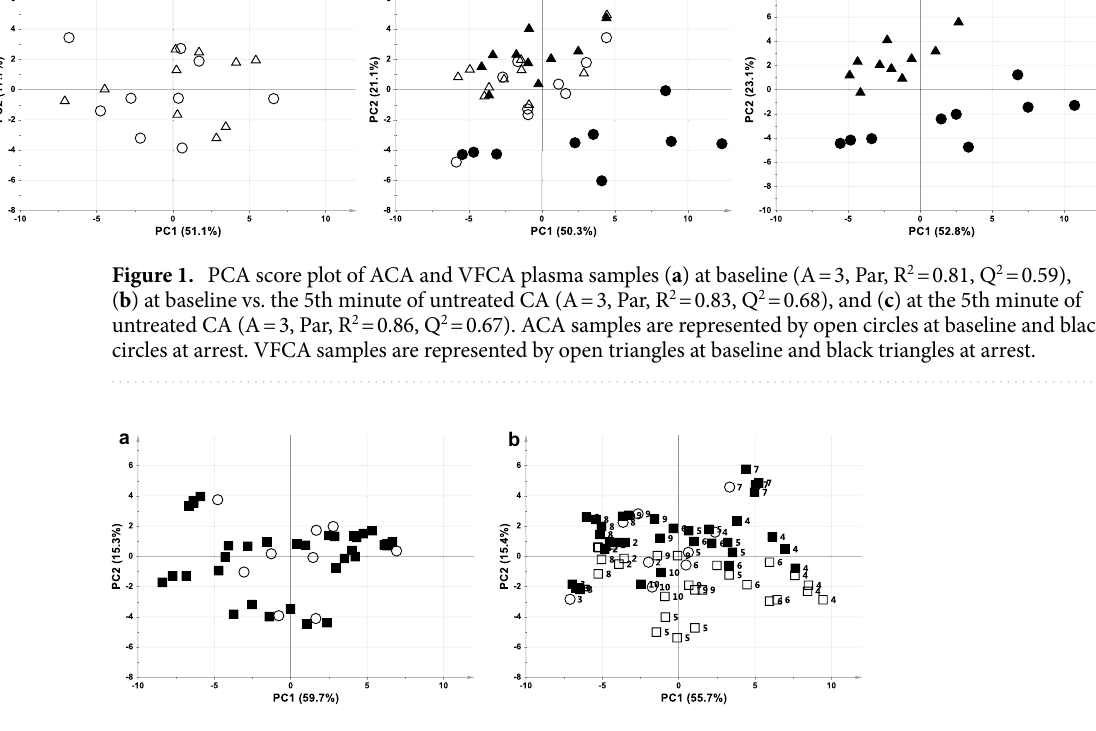
Figure 2. PCA score plot of ACA plasma samples collected at ( a ) baseline vs. the first 4 min of the pre-arrest phase (A = 3, Par, R 2 = 0.84, Q 2 = 0.73), ( b ) baseline vs. all pre-arrest samples (A = 3, Par, R 2 = 0.82, Q 2 = 0.71). Samples are represented by open circles at baseline, black squares at pre-arrest ≤ 4 min, and open squares at pre- arrest ≥ 5 min. Labels correspond to the animal